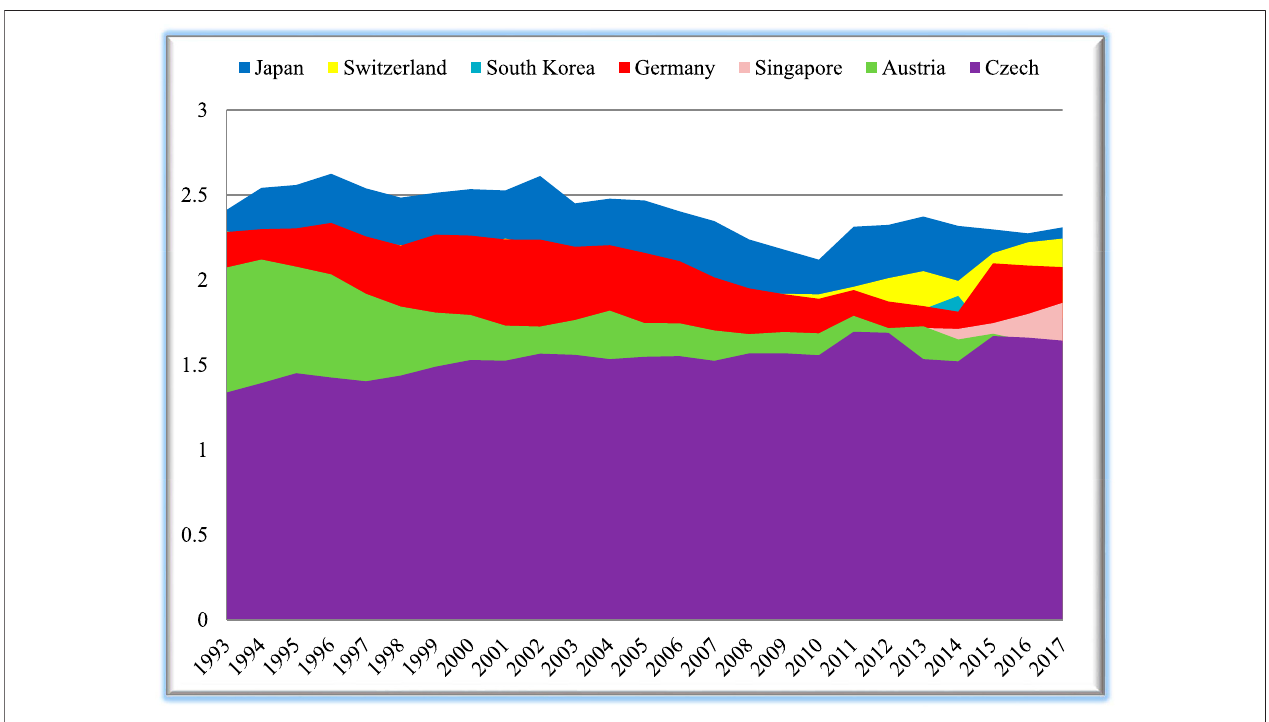
FIGURE 1 | Top 7 economic complexity nations trends from 1993 to